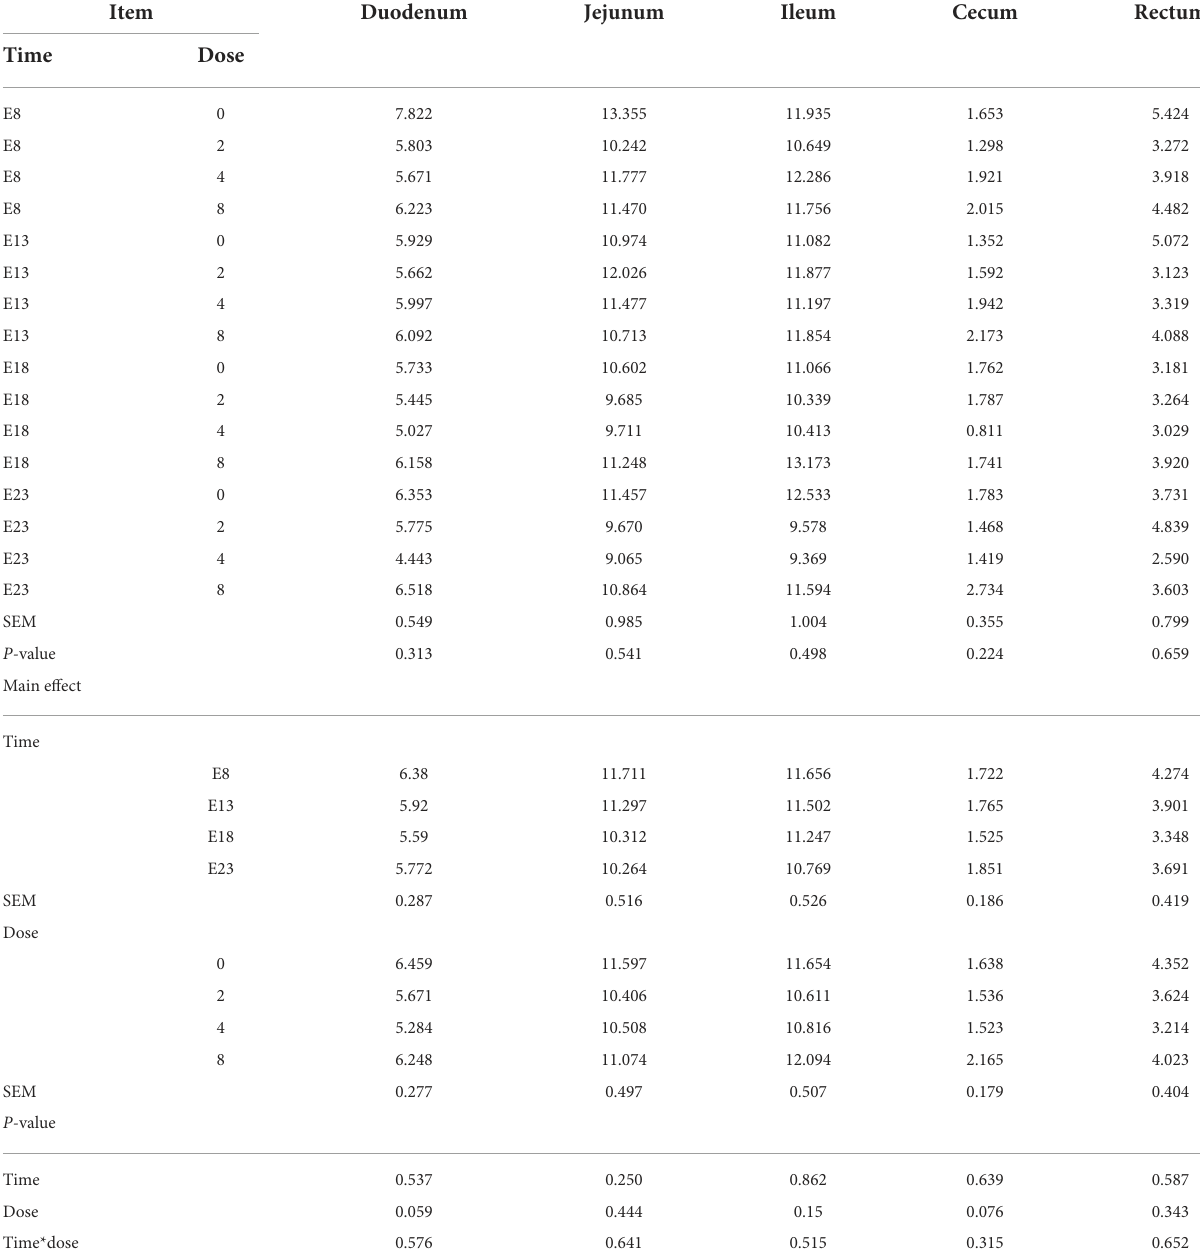
TABLE 2 Effect of time and doses of an embryo injected OTA on the intestinal relative weight of ducks at hatching 1 (g/kg). Item Duodenum Jejunum Ileum Cecum